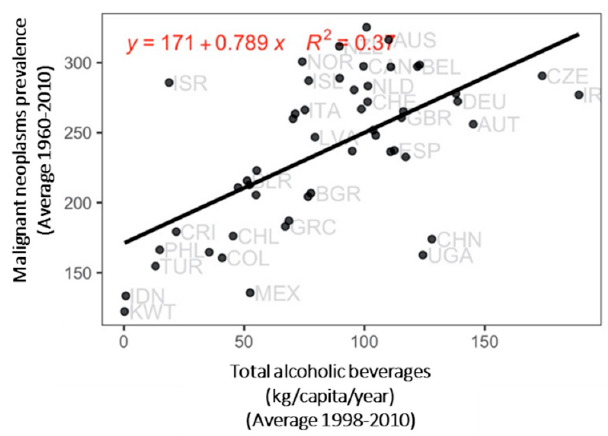
Figure 4. Relationship of the prevalence (per 100,000 population) of malignant neoplasms per country with the annual mean intake of alcoholic beverages. p < 0.001.